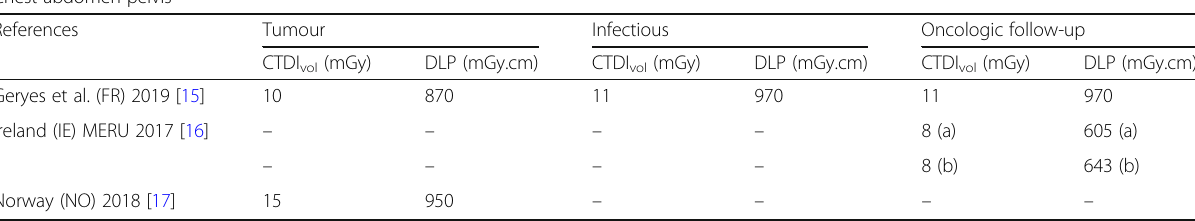
Table 7 DRL ci for chest-abdominopelvic CT Chest abdomen